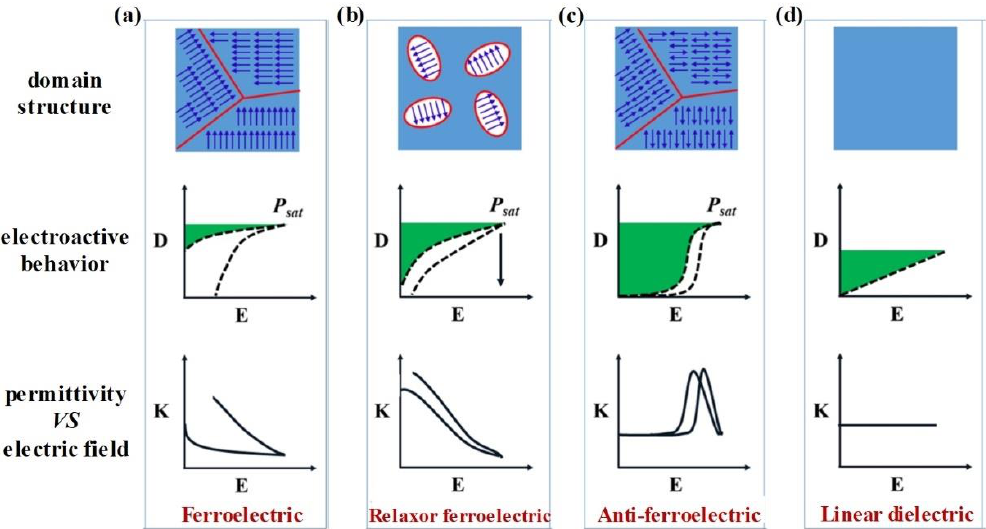
Figure 3. Schematic showing the typical classification of dielectric materials ( a ) Ferroelectric, ( b ) Relaxor ferroelectric, ( c ) Anti-ferroelectric, ( d ) Linear dielectric. Reproduced with permission from Ref. [21]. Copyright 2018, Elsevier.